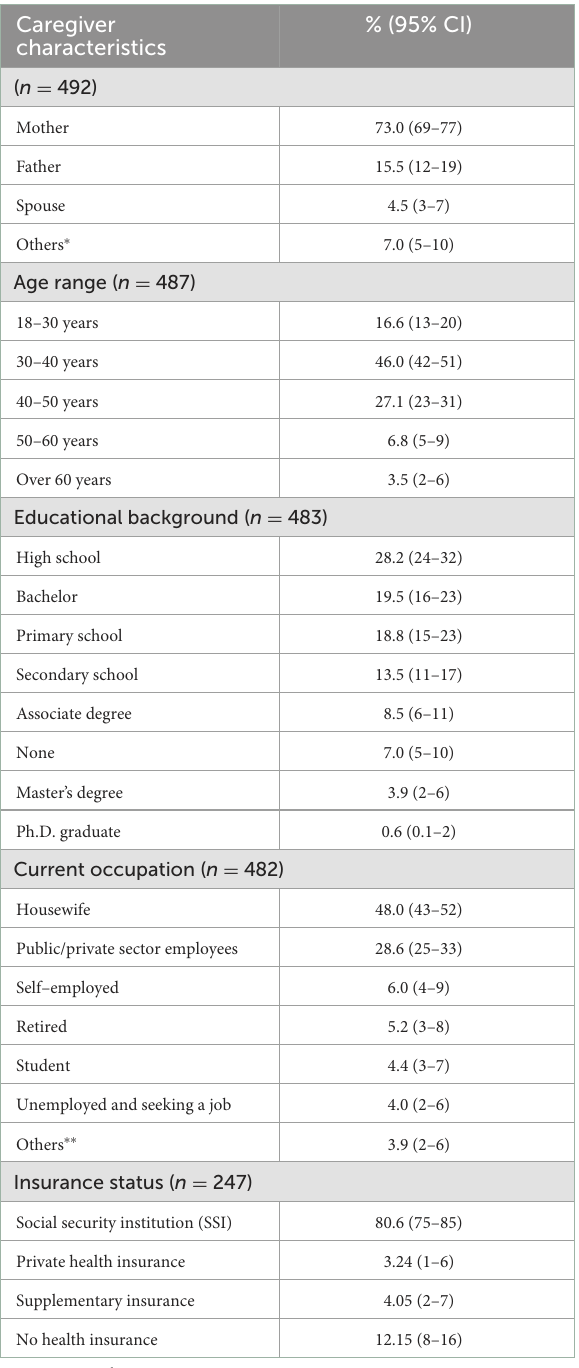
TABLE 3 The profile of the patients’ primary caregivers. Caregiver